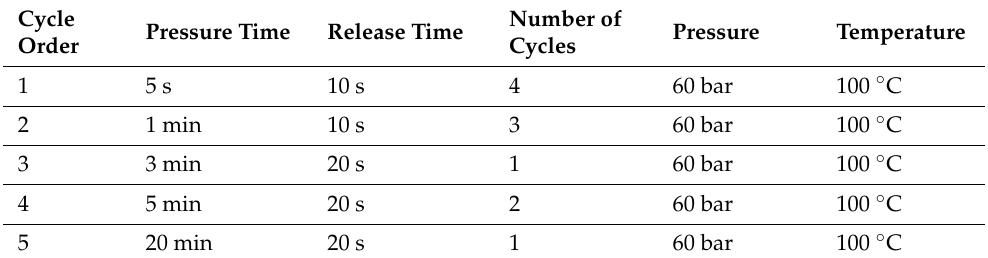
Table 1. Pressing cycles in composite manufacturing for the hot press process. Cycle Pressure Time Release Order